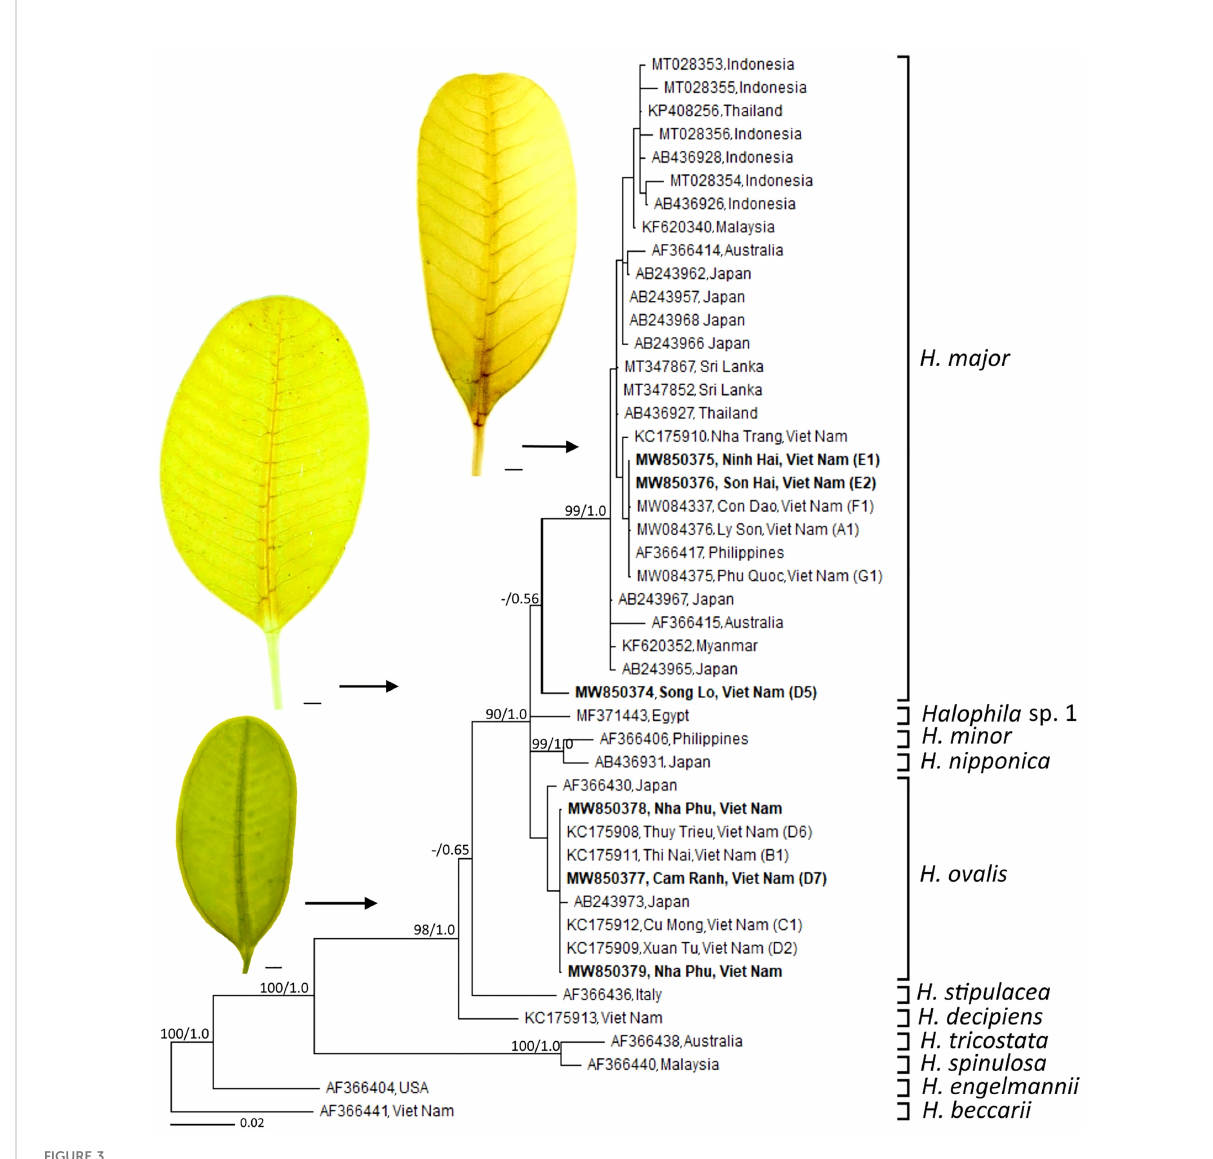
FIGURE 3 Phylogeny of members of the genus Halophila 612 bp of the ITS1-5.8S-ITS2 sequence. Leaf morphology of Halophila spp. from samples collected in Viet Nam were placed beside the phylogenetic tree. Scale in each leaf fi gure = 1 mm. The fi gure was modi fi ed from Nguyen et al.